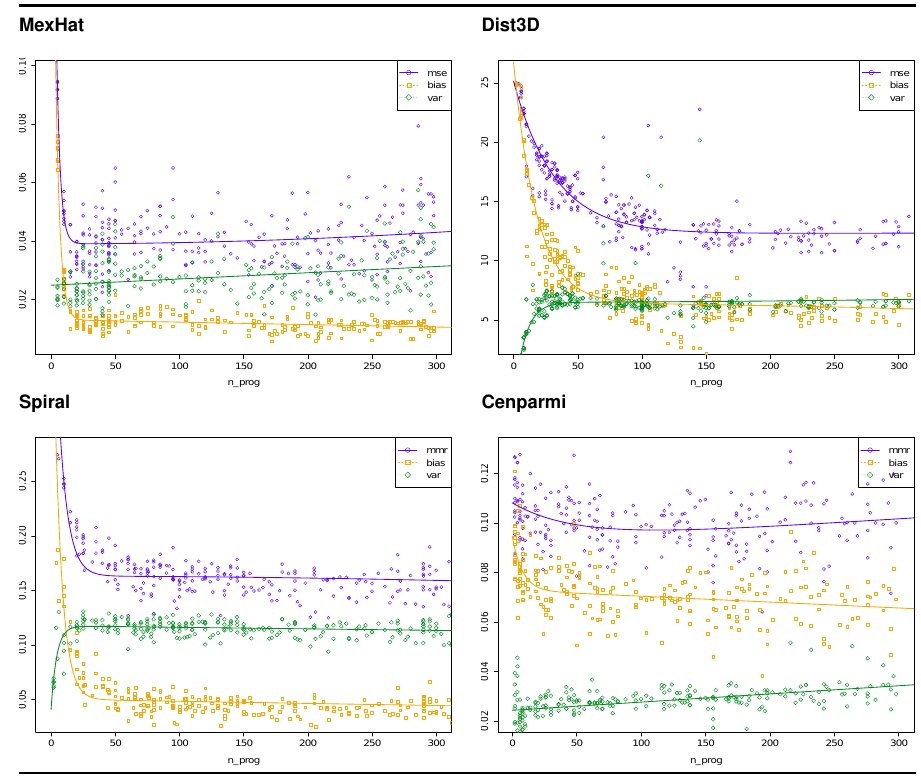
Fig. 4. Best-fit curves of c bias (orange, using err 4 ), b var (green, using using err 4 or a straight line) and c mse or varying over n prog